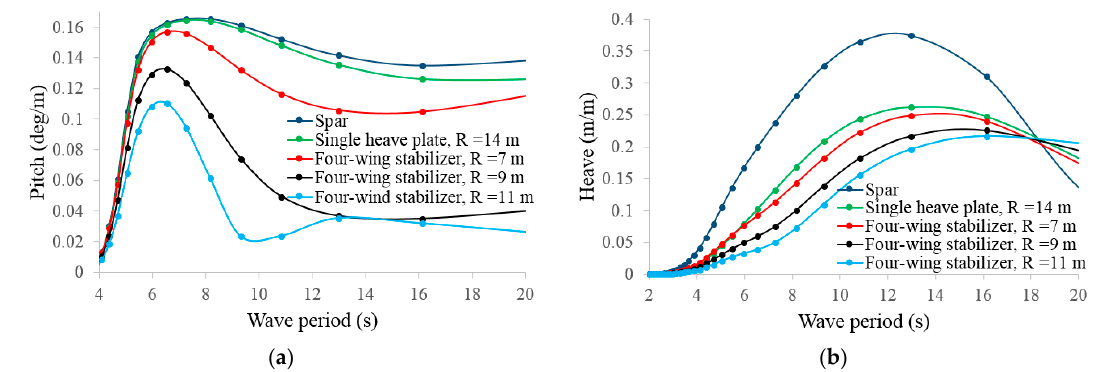
Figure 5. ( a ) Pitch and ( b ) heave motions obtained in numerical tests.